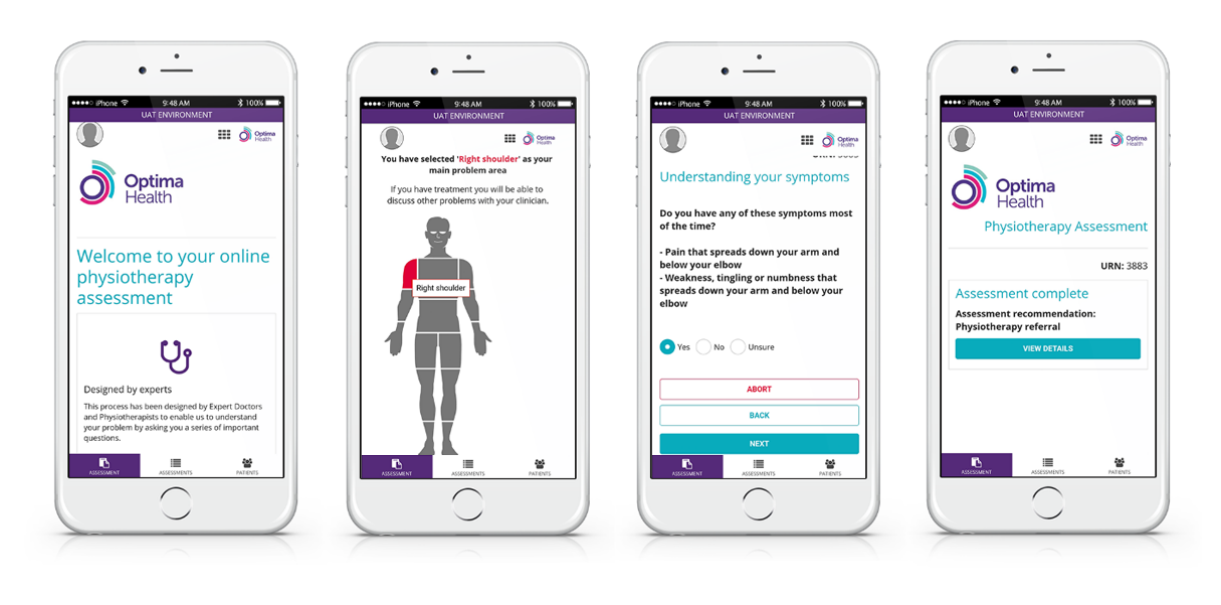
Figure 2. Digital Assessment Routing Tool mobile health